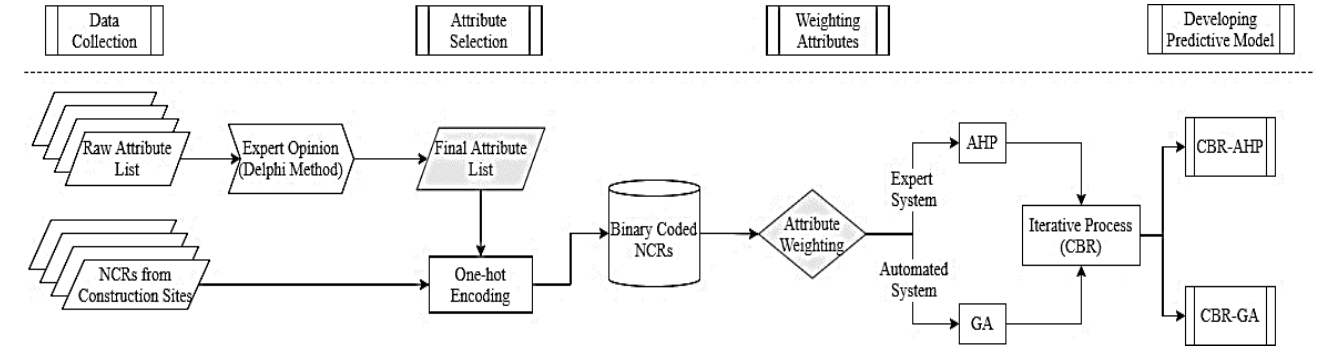
Figure 1. Research Methodology Flow.